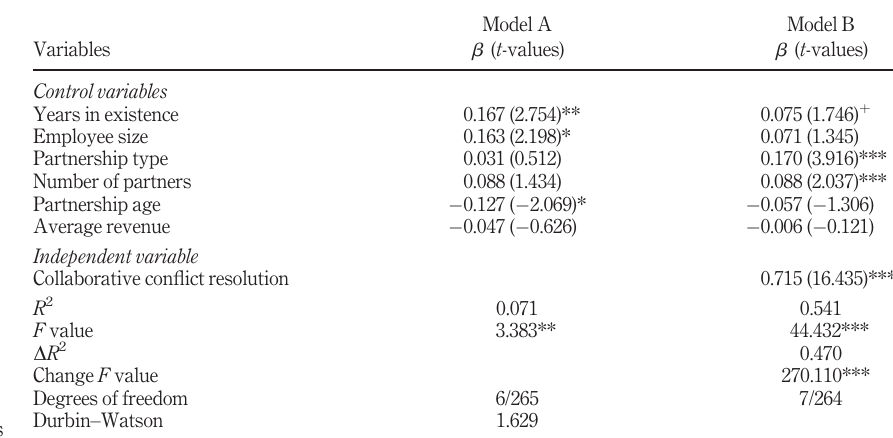
Table 7. Regression analysis of con fl ict resolution on the success of